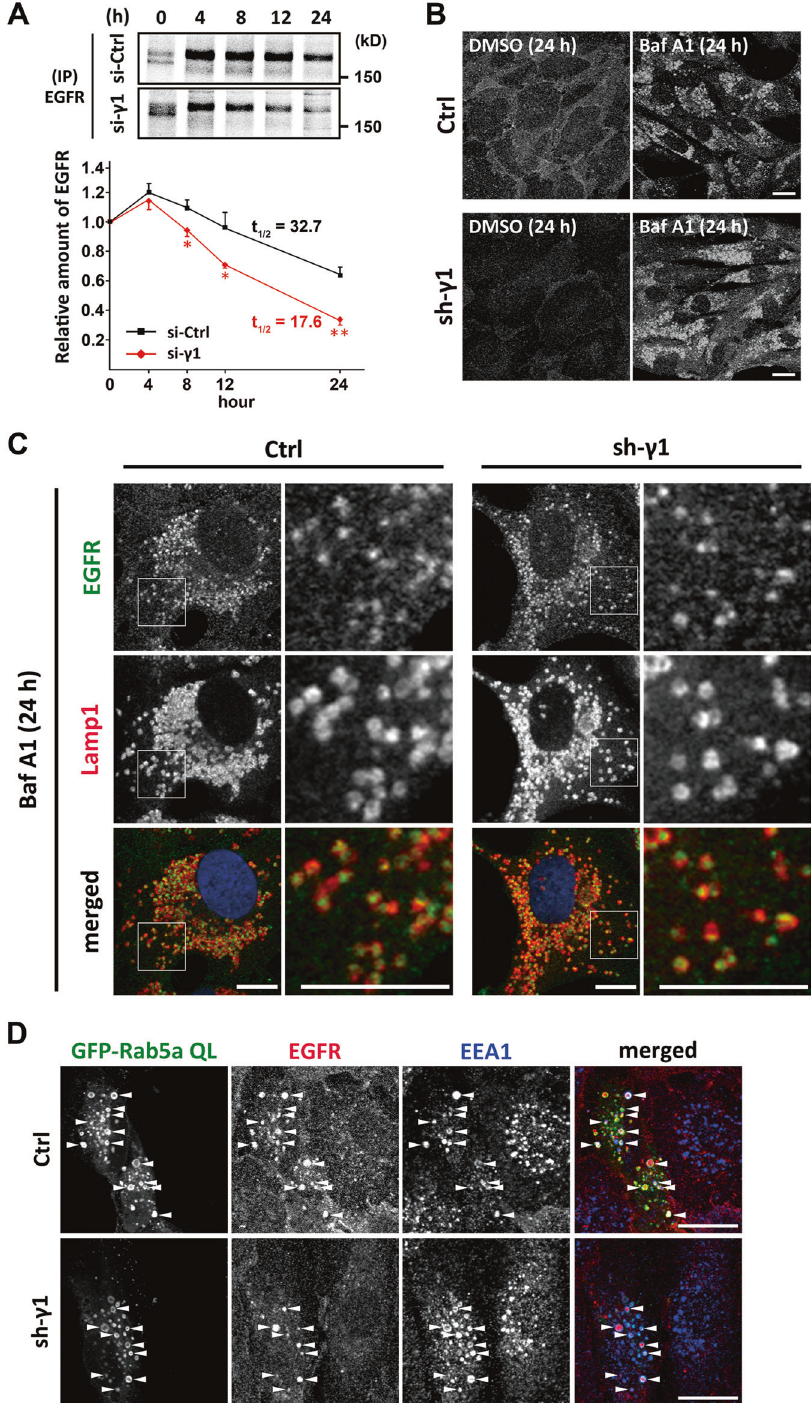
Fig. 2 AP-1-depletion accelerates lysosomal degradation of EGFR protein. A ARPE-19 cells transfected with si-Ctrl or si- γ 1 were pulse- labeled with [ 35 S]-methionine/cysteine for 2 h and chased for the indicated periods. The cell lysates were immunoprecipitated (IP) with anti- EGFR antibodies, followed by SDS-PAGE. The lower band of the doublet at 0 h corresponds to non-glycosylated precursor form of EGFR. The value of each time point was normalized to that at 0 h chase, and plotted on the graph as the mean ± SD (of three experiments). Statistical differences between si-Ctrl and si- γ 1 at each time point were analyzed using Student ’ s t -test (* P < 0.05 and ** P < 0.01). B Control (Ctrl) and AP- 1-depleted (sh- γ 1) ARPE-19 cells were treated with 100 nM ba fi lomycin A1 (Baf A1) or DMSO for 24 h, and fi xed for immuno fl uorescence microscopy using anti-EGFR antibodies. Bars, 20 μ m. C Ctrl and sh- γ 1 cells were treated with 100 nM Baf A1 for 24 h, and fi xed for double immuno fl uorescence microscopy using anti-EGFR (green) and anti-Lamp1 (red) antibodies. Nuclei were stained with Hoechst 33342 (blue). Bars, 10 μ m. D Ctrl and sh- γ 1 cells transfected with GFP-Rab5a QL (green) were fi xed for double immuno fl uorescence microscopy with anti- EGFR (red) and anti-EEA1 (blue). Arrowheads indicate colocalization of three signals. Bars, 20 μ